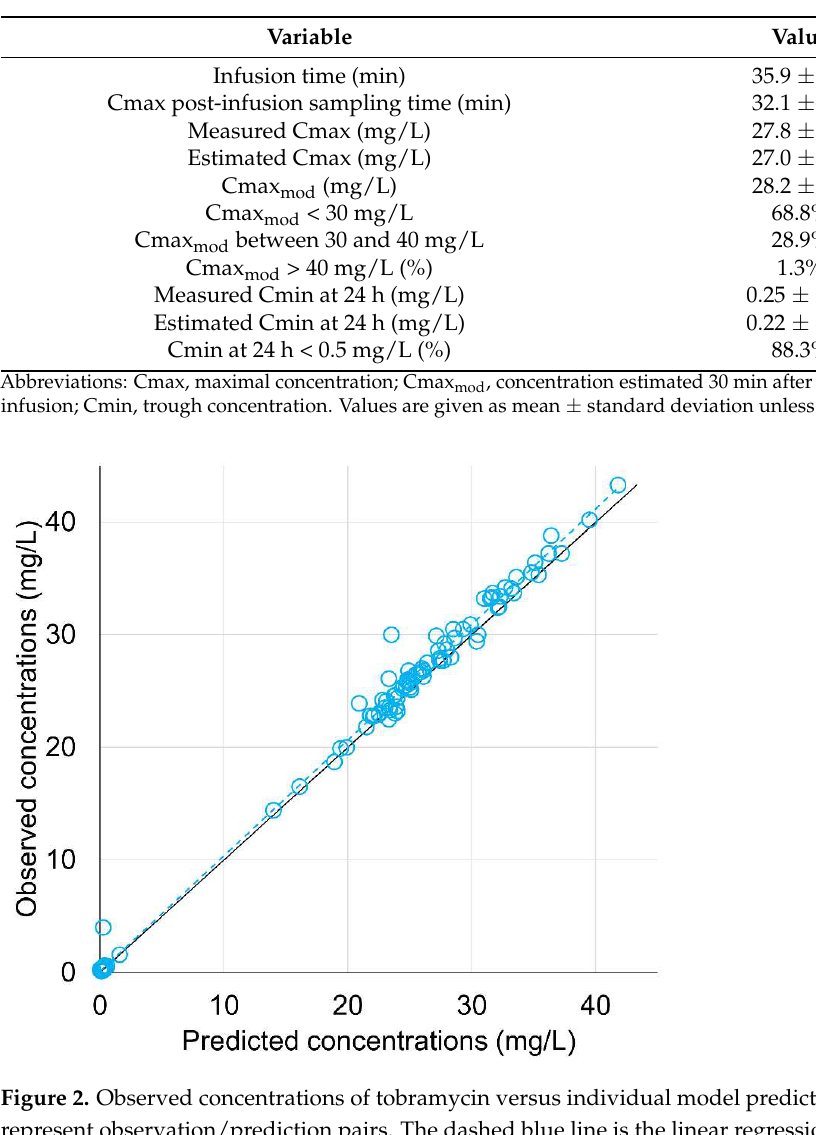
Table 2. Pharmacokinetic results.